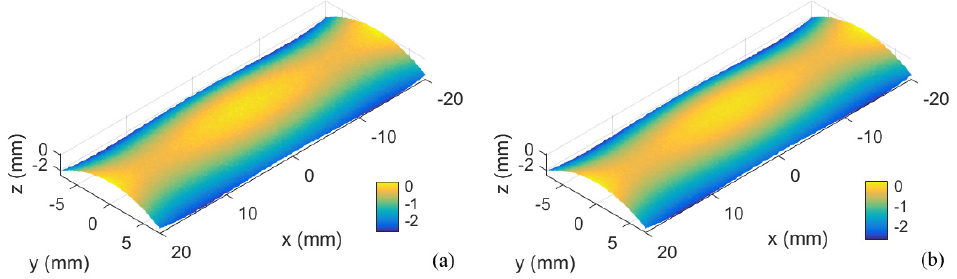
Figure 10. Simulated measurement results of the designed f ‐ theta lens surface: ( a ) with 40 μ m measurement noise; and ( b ) with 30 μ m measurement noise